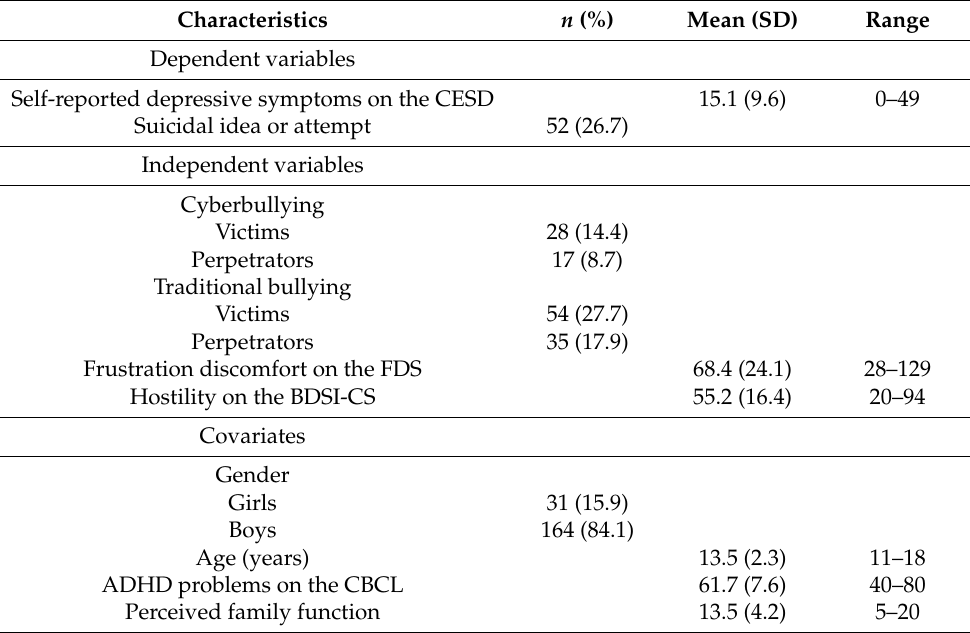
Table 1. Dependent variables, independent variables, and covariates ( N =